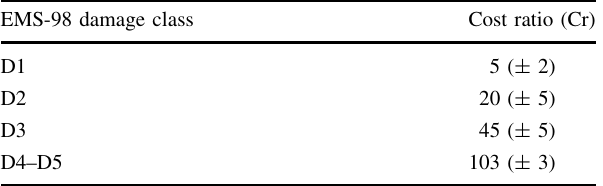
Table 5 Adopted cost ratio values (decrease of construction value in percentage) EMS-98 damage